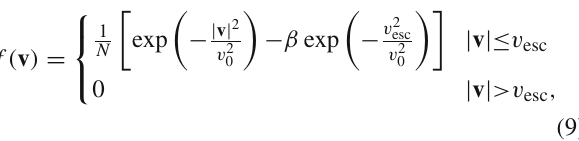
respectively. In the lower panel we show the corresponding fractional changes relative to the fiducial choice in the SHM (defined in Eq. (8)). The uncertainties associated with the recent astrophysical observations are utilized to form light blue shaded bands. Whereas the blue dashed curves denote the relative fractional changes in the Modified Maxwell– Boltzmann distribution for F DM = 1